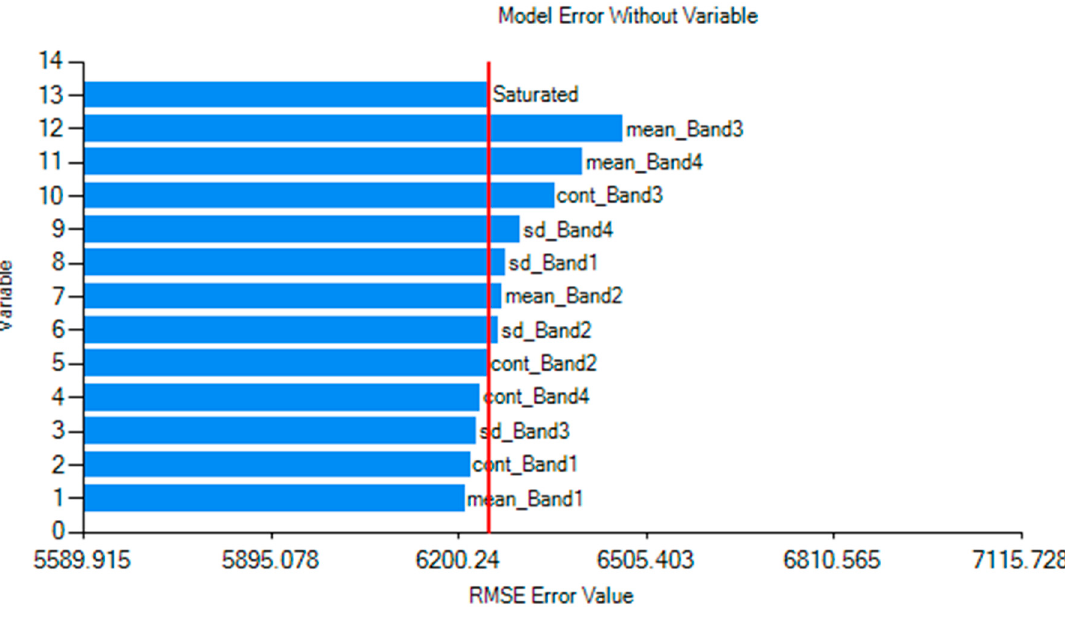
Figure 3. An example of the interactive graphics produced within the RMRS Raster Utility toolbar that depicts the importance of each variable within a predictive model by systematically removing one variable from the model and comparing changes in root mean squared error (RMSE). The model used is a generalized association between board foot volume per acre and twelve explanatory variables derived from remotely sensed imagery, and was developed using a random forest algorithm and the RMRS Raster Utility toolbar.